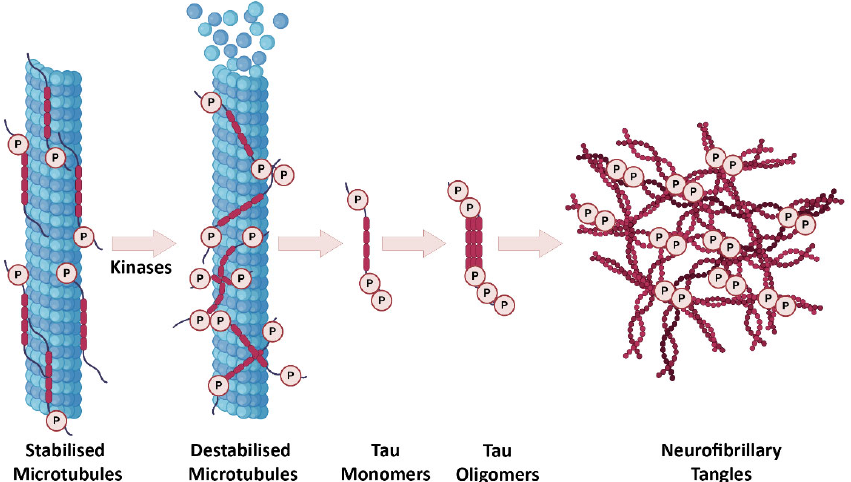
Figure 2. The progression of tau pathology in AD. In a healthy brain, tau is involved in regulation of microtubule stabilization. After tau hyperphosphorylation, microtubules are destabilized and start to disassemble. Tau monomers and oligomers subsequently occur intraneuronally and eventually formation of NFTs takes place. Created partially with BioRender.com (accessed on 28 June 2021).